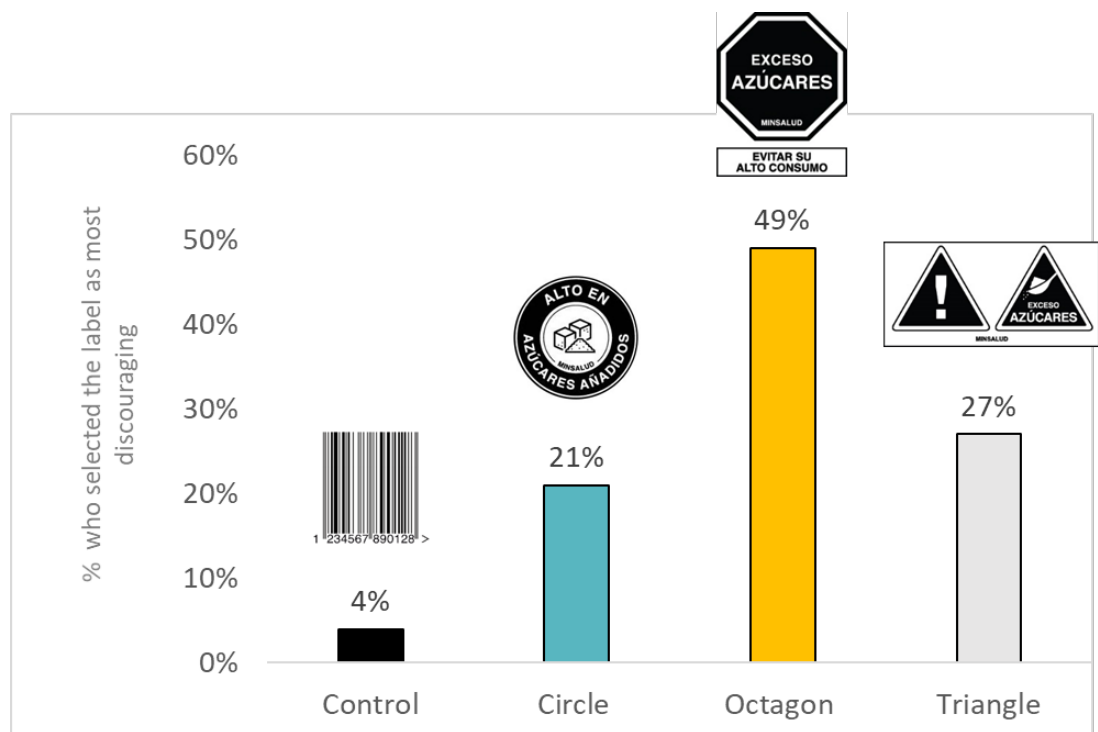
Figure 4. Percent of participants who selected a label as the one that would most discourage them from consuming a product high in sugar, sodium, or saturated fat. Note. The images refer to sugar, but the results are across all products.